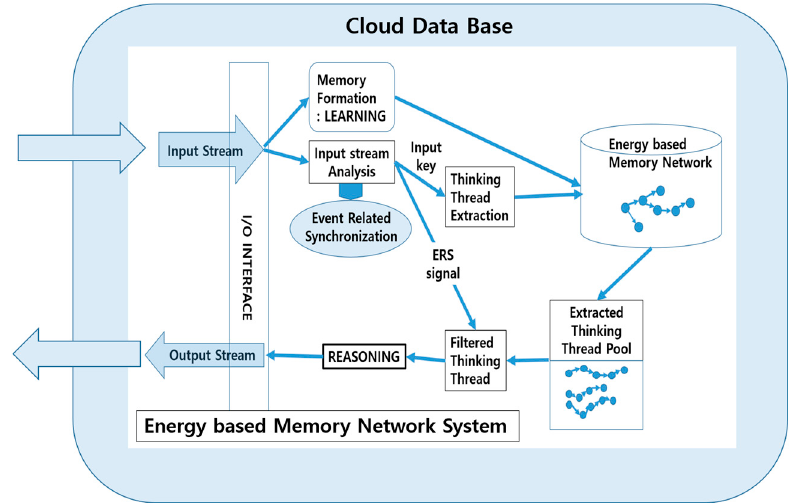
Figure 5. The Structure of an Energy-based Memory Network System as a Cloud Database.